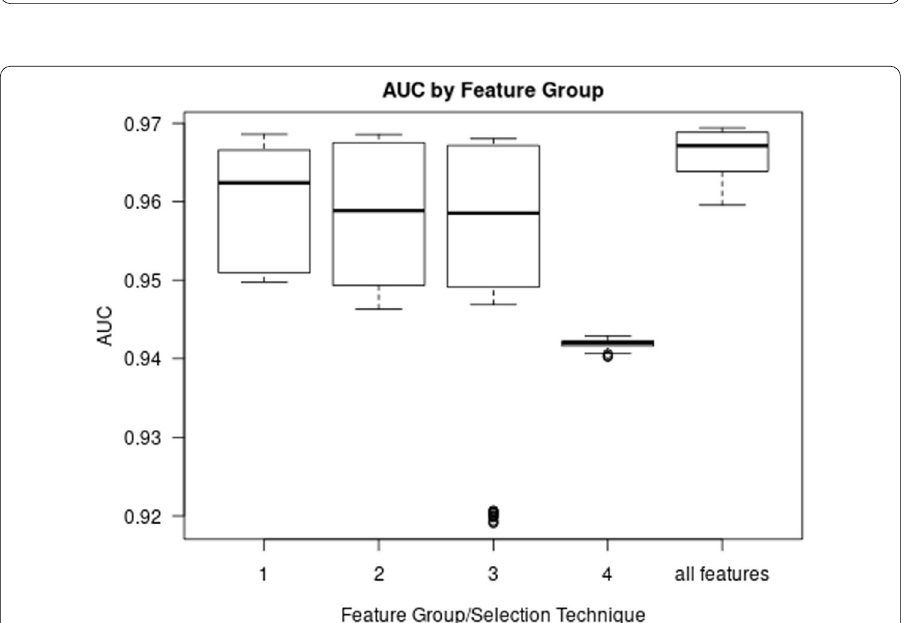
Fig. 6 Box plots of AUC grouped by feature group/selection technique; here datasets include destination port; Tukey’s HSD test indicates feature selection techniques 1 and 2 are not significantly different, and other techniques are in groups of their